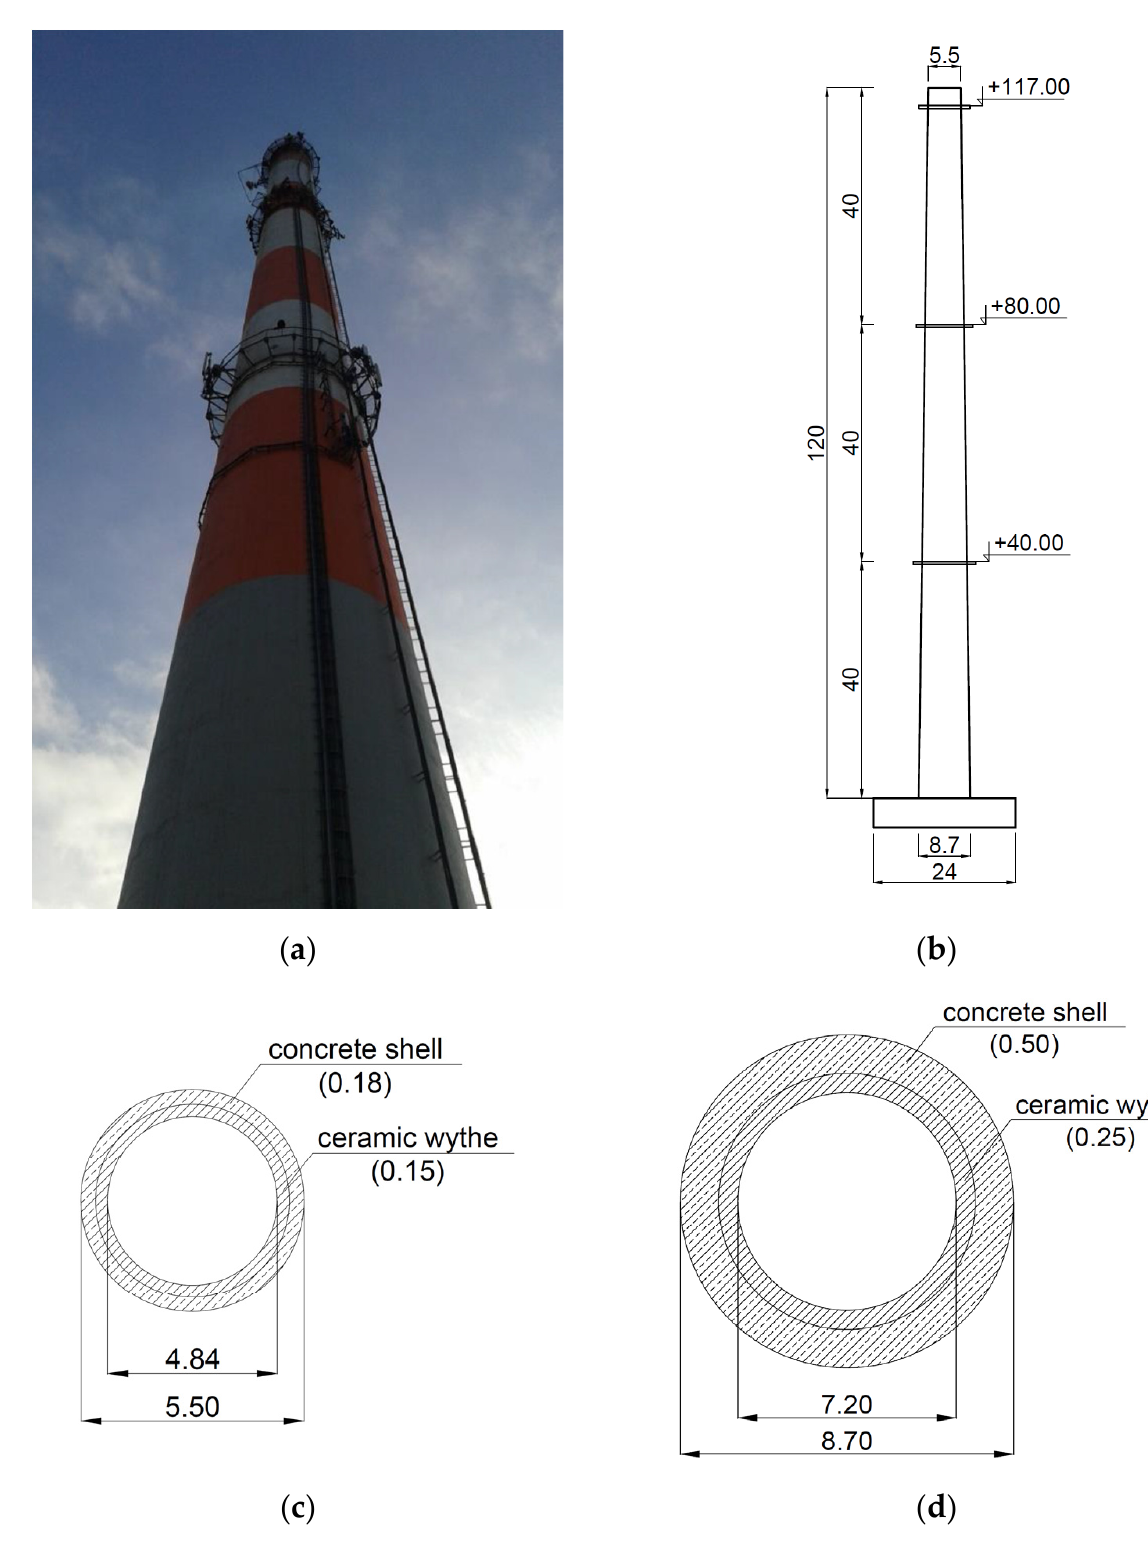
Figure 2. The analyzed chimney (the prototype): ( a ) The general view; ( b ) the main vertical dimen- sions [m]; ( c ) the dimensions of the cross-section at the top [m]; ( d ) the dimensions of the cross-section at the bottom [m].